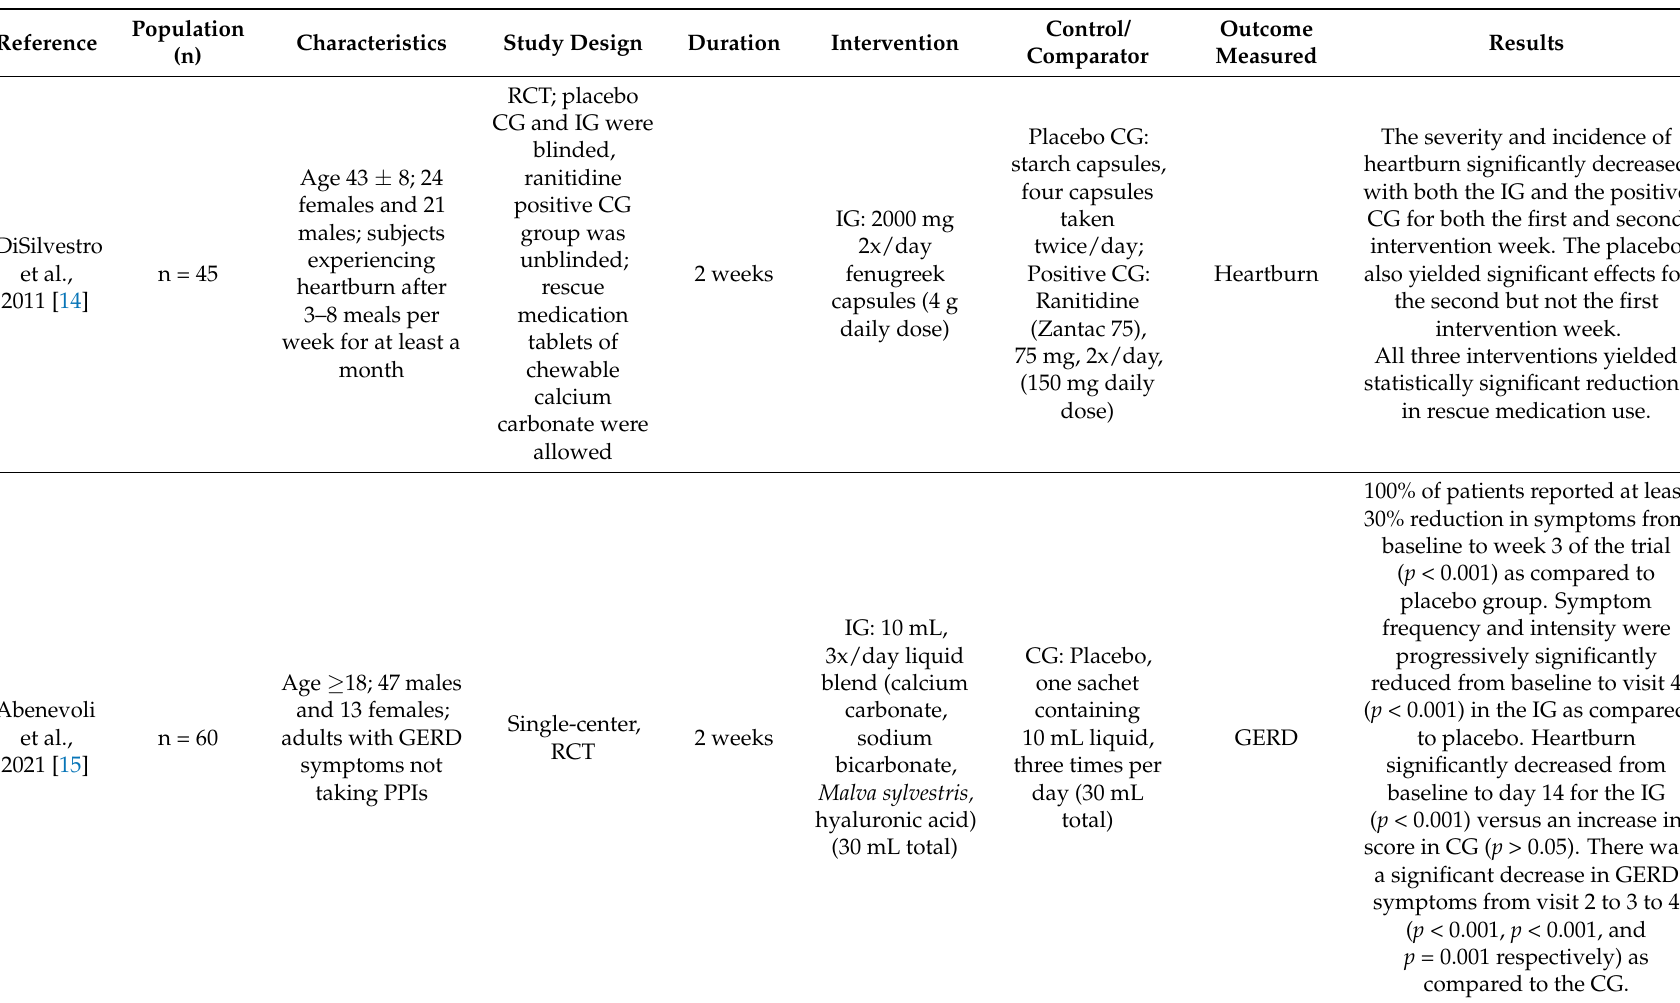
Table 4. Summary of human trials on botanical fiber ingredients and upper GI